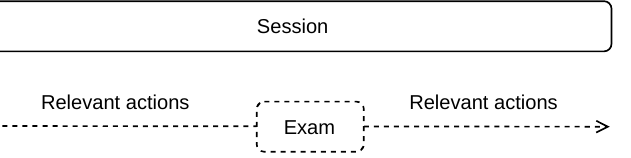
Figure 2. Relevant actions for student cheating indication are found before and after the exam within a session.